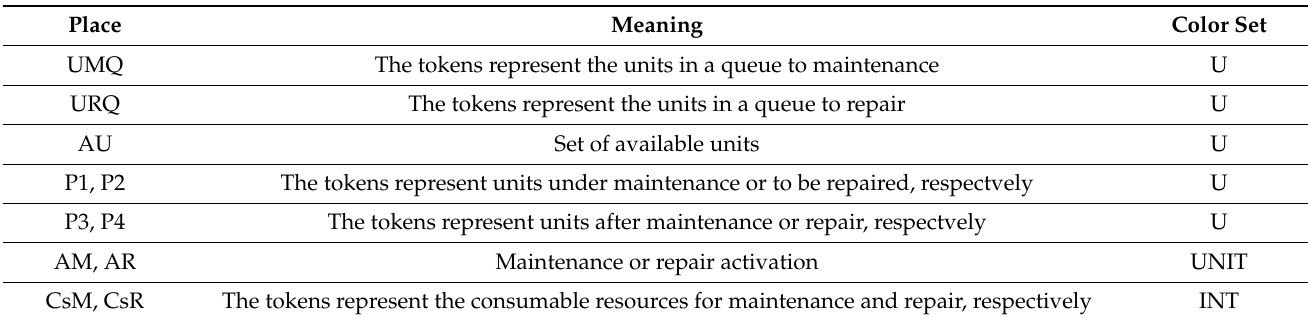
Table 4. Places of MR module.